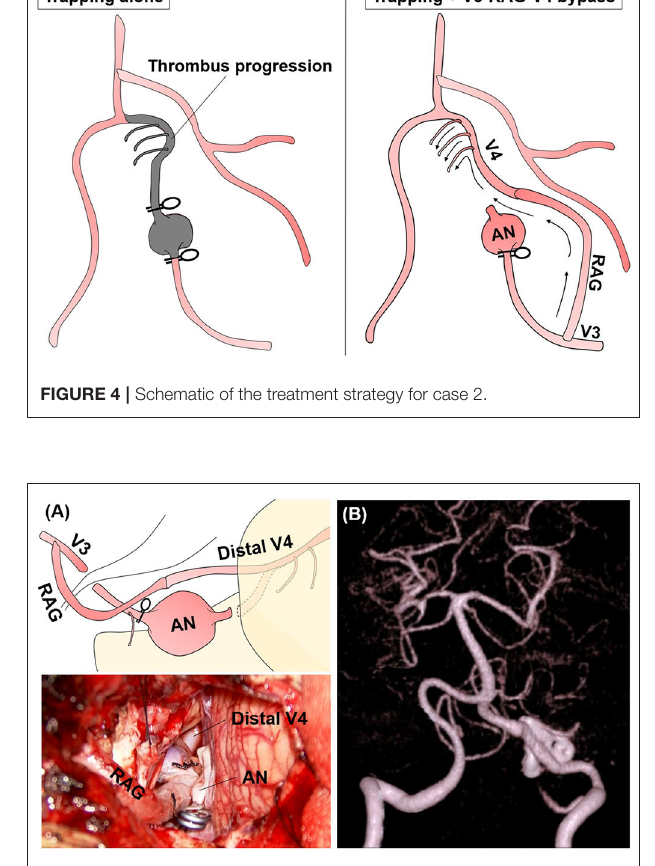
FIGURE 2 | Intraoperative findings and postoperative computed tomography angiography (CTA) of case 1. (A) Intraoperative findings. (B) Postoperative CTA.